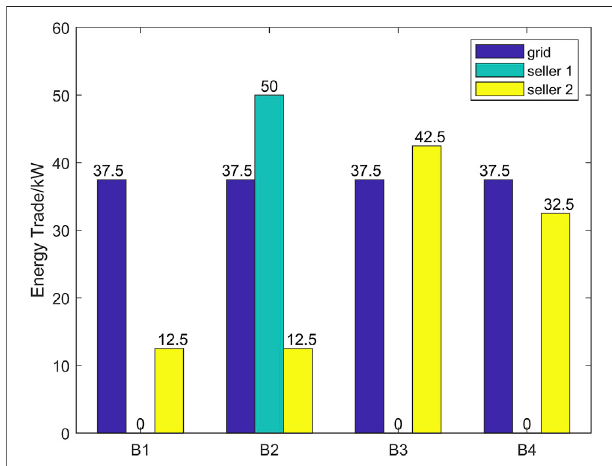
FIGURE 6 | Buyers ’ energy resources.